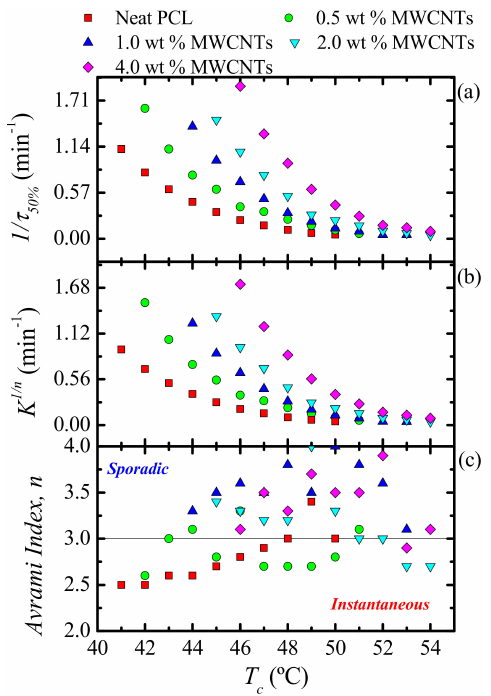
Figure 20. ( a ) Inverse of half crystallization times (1/ τ 50% ) ( b ) Normalized crystallization constant of the Avrami model ( K 1/ n ) and ( c ) Avrami index ( n ) as a function of the isothermal crystallization temperature ( T c ) for all the